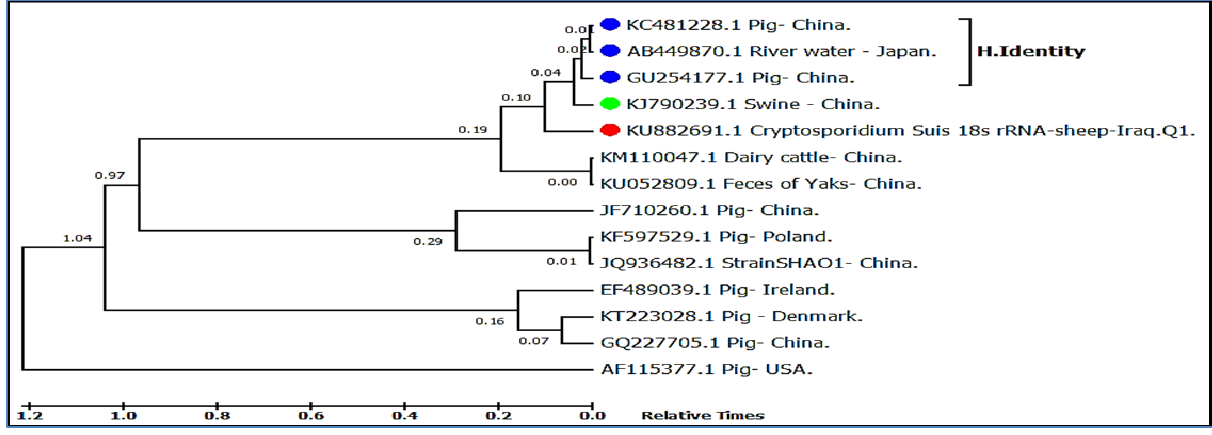
Figure, 8: Phylogenetic tree depend on the Neighbor joining tree method. The phylogenetic distances analyses were conducted by MEGA6.*Red spot: C. suis strain isolated from Iraq. *Green spot: Strain high homologous with Iraqi – C. Suis isolated from sheep.*Blue spot: Strains highly identity with Iraqi – C. suis isolated from